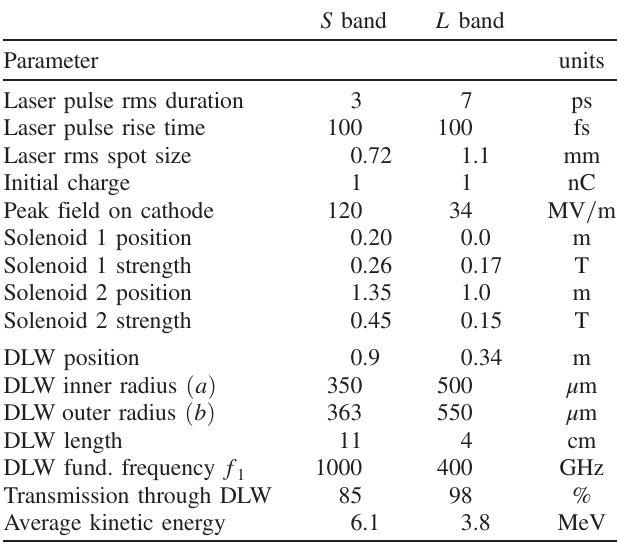
TABLE I. Beam line settings and DLW-structure parameters used in the ASTRA simulations. The beam line configuration with some of the associated parameters is depicted in Fig.